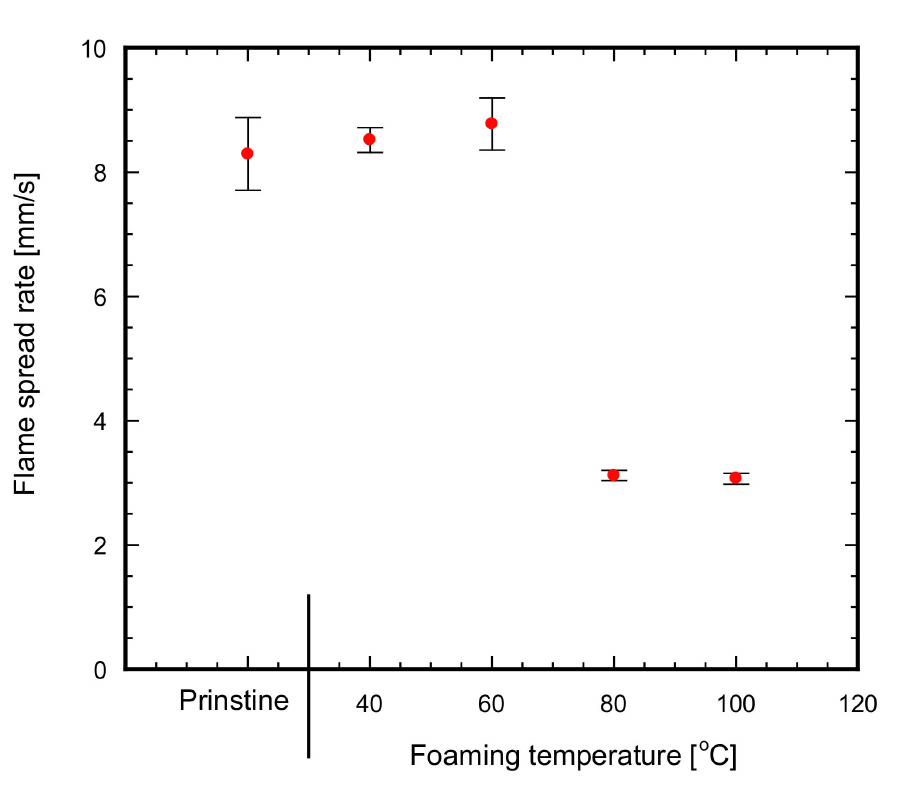
Figure 10. Flame spread rate as function of PET–PEN foaming temperature. Vertical line represents error